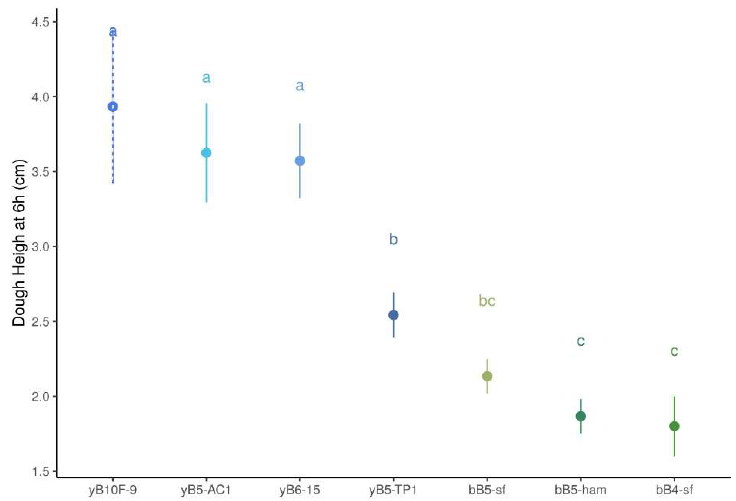
Figure 2. Dough height for monocultures at 6 h for yeast strains in blue (dashed lines for S. cerevisiae and plain lines for K. humilis ) and obligately heterofermentative LAB strains in green. Compact letter display on top indicate Tuckey’s statistical groups.